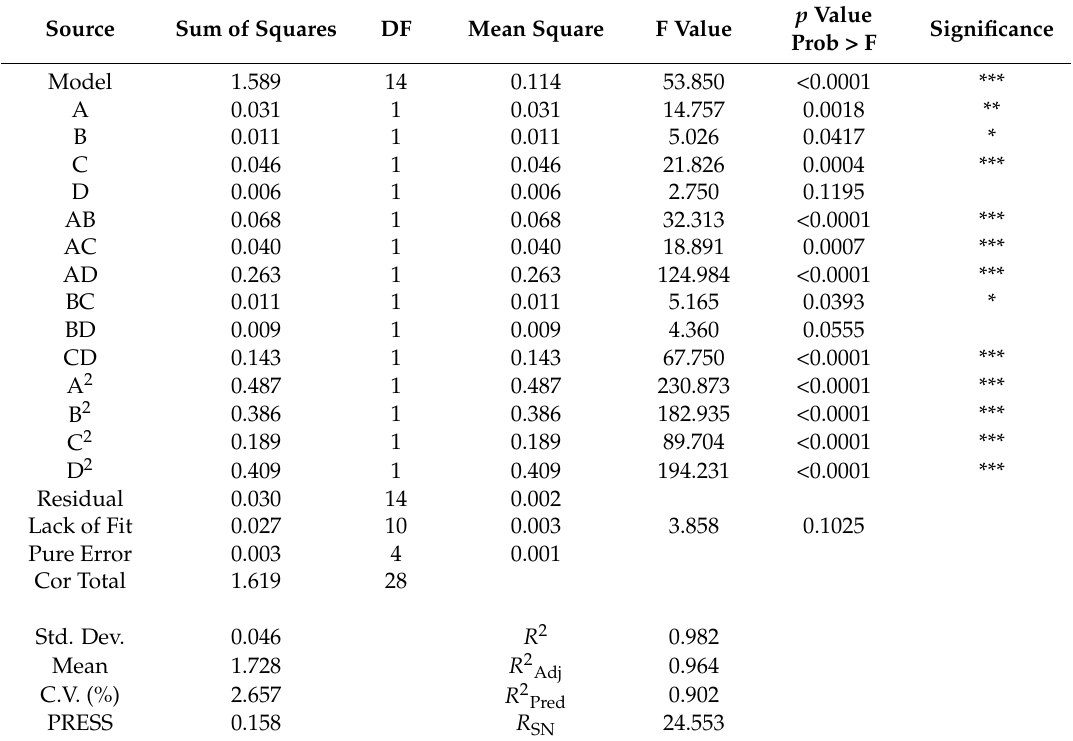
Table 2. The results of analysis on variance (ANOVA) for the effects of